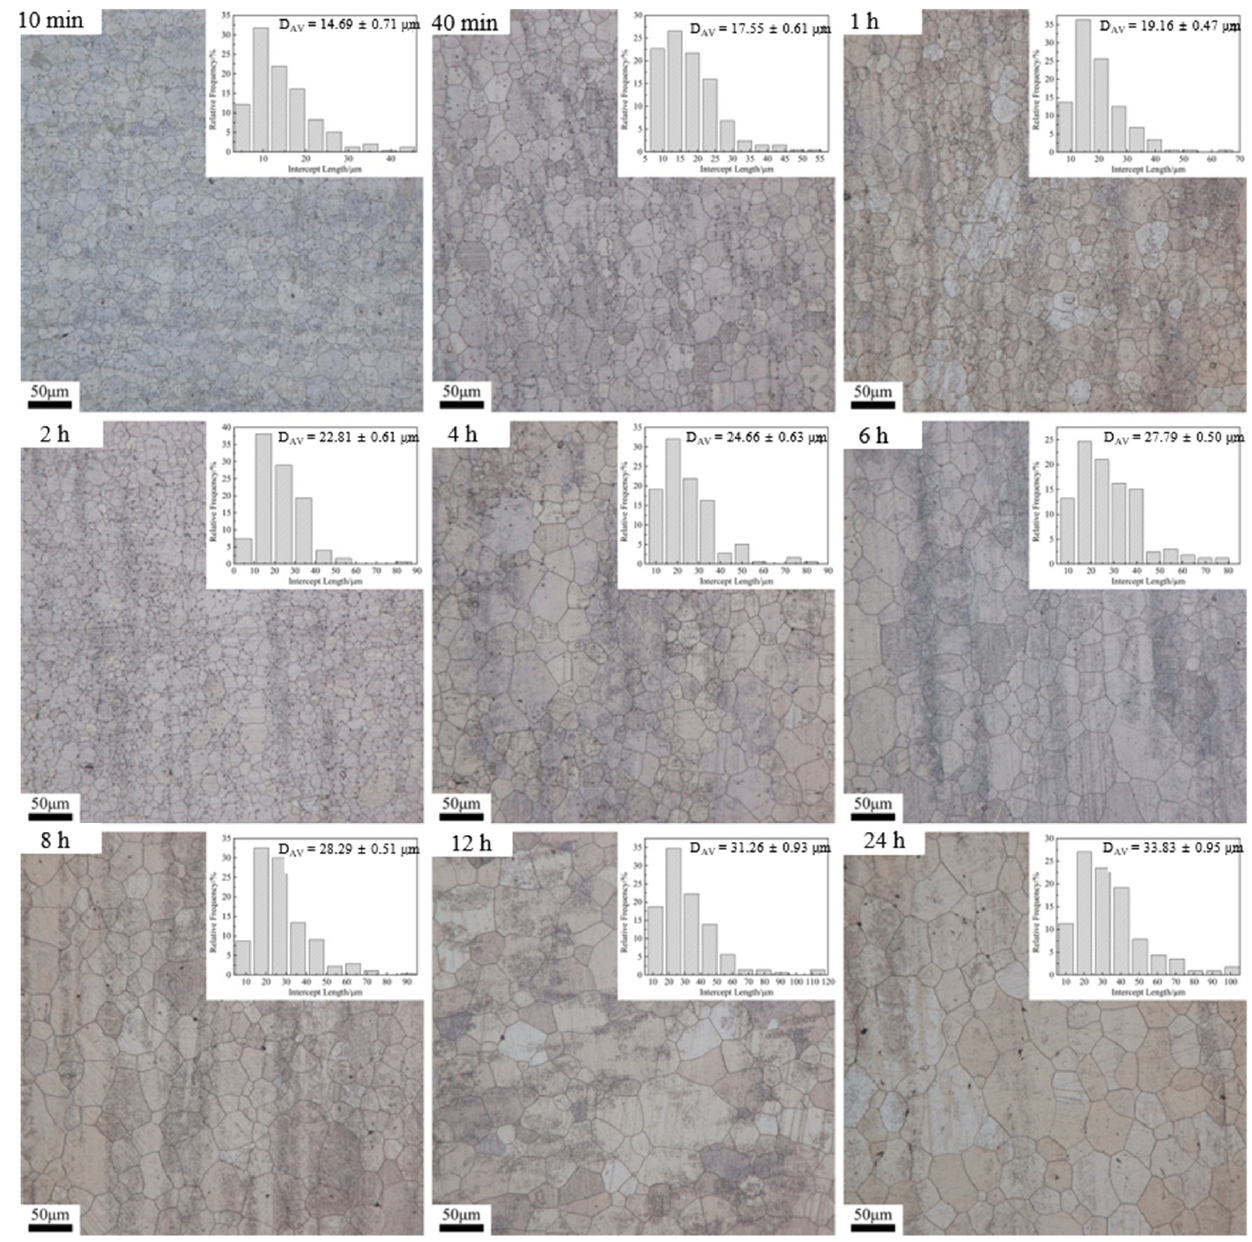
Figure 4. Optical micrographs and the corresponding grain-size distribution histograms obtained upon annealing at 530 °C.